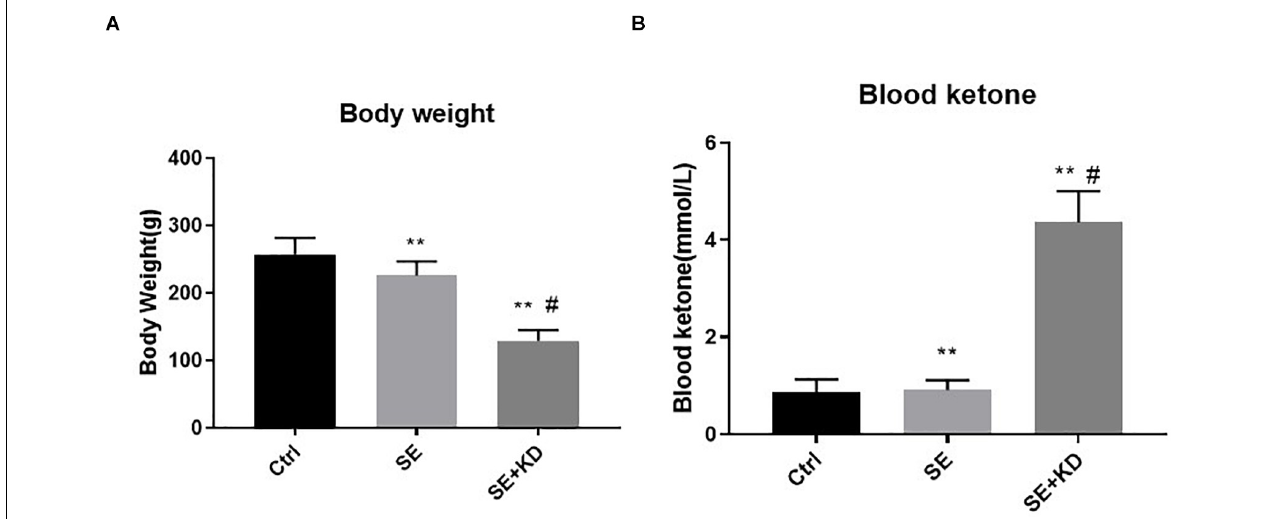
FIGURE 1 | Comparison of body weight (A) and blood ketones (B) among control (Ctr), seizure (SE), and seizure with ketogenic diet (SE + KD) groups at P49 ( n = 10 rats/group). Body weights were significantly reduced in SE and SE + KD groups compared to the Ctr group, and significantly lower in the SE + KD group compared to the SE group. Blood ketone level was significantly higher in the SE + KD group compared to Ctr and SE groups, but did not differ between Ctr and SE groups. ** p < 0.01compared to Ctr group, # p < 0.01 compared with SE